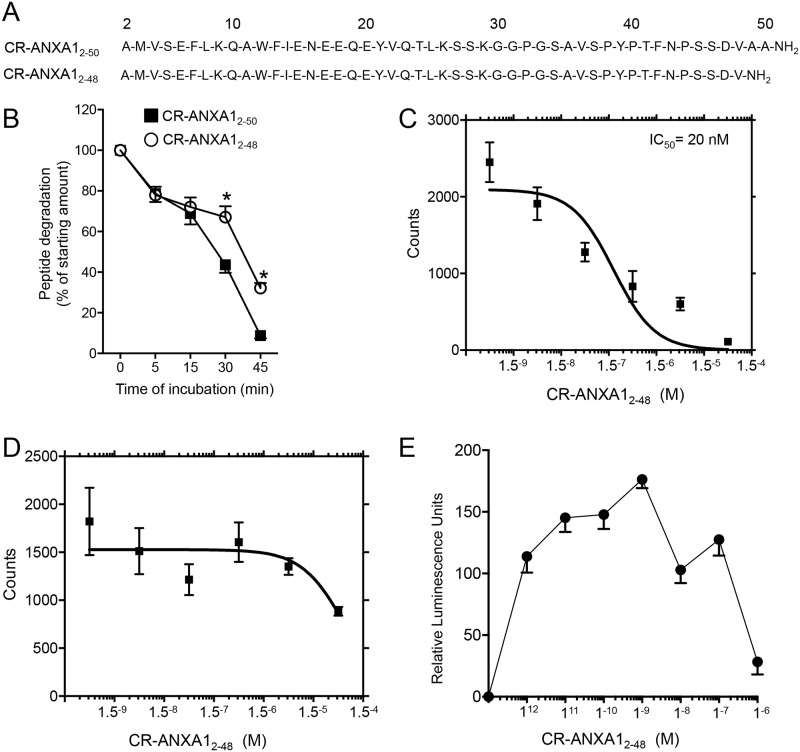
CR-AnxA12-48 is resistant to neutrophil mediated cleavage and selectively binds the ALX receptor.(A) Aminoacid sequences for CR-AnxA12–50 and CR-AnxA12–48
(B) Plots depicting the amount of peptide remaining at the indicated intervals in incubations of human neutrophil with CR-AnxA12–50 or CR-AnxA12–48. Results are mean ± SEM of n = 4 distinct incubations with different neutrophil preparations. *p < 0.05 versus AnxA12–48 incubations. (C,D) Binding affinity of CR-AnxA12–48 to (C) human ALX-overexpressing and (D) FPR1-overexpressing HEK cells was assessed in a competitive binding assay using [125I]–Ac2-26. (E) Agonist activity of CR-AnxA12–48 was investigated using β-arrestin stably expressing FPR2/ALX. Results for C-E are mean ± SEM of 3–4 independent experiments.